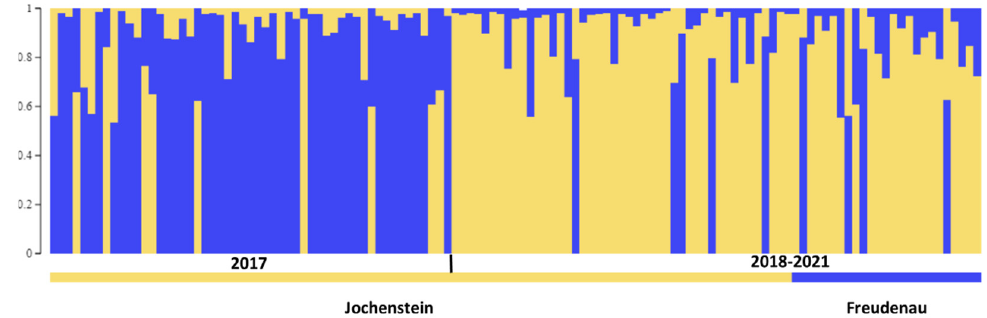
Figure 3. Assignment of 123 sterlets from Jochenstein (J) and Freudenau (F), considering only samples above the 75% threshold and calculated in Structure 2.3.4. (K = 2). Q values, sample numbers, and details for the samples are given in Supplementary Table S2.